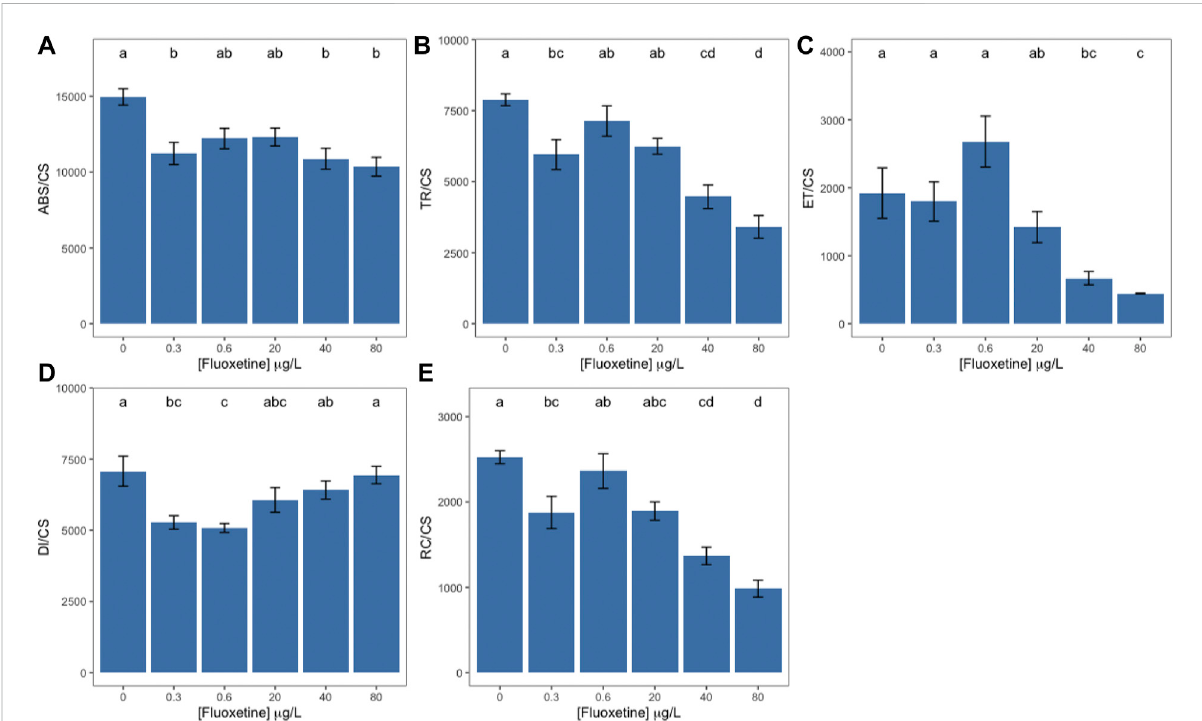
FIGURE 2 Ulva lactuca phenomological energy fl uxes following a 48-h exposure to different fl uoxetine concentrations. (A) Energy absorption per cross section (ABS/CS). (B) Trapped energy per cross section (TR/CS). (C) Electron transport per cross section (ET/CS). (D) Energy dissipation per cross section (DI/CS). (E) Number of reaction centres available per cross-section (RC/CS). Average ± standard error, N = 5; different letters indicate signi fi cant differences at p <